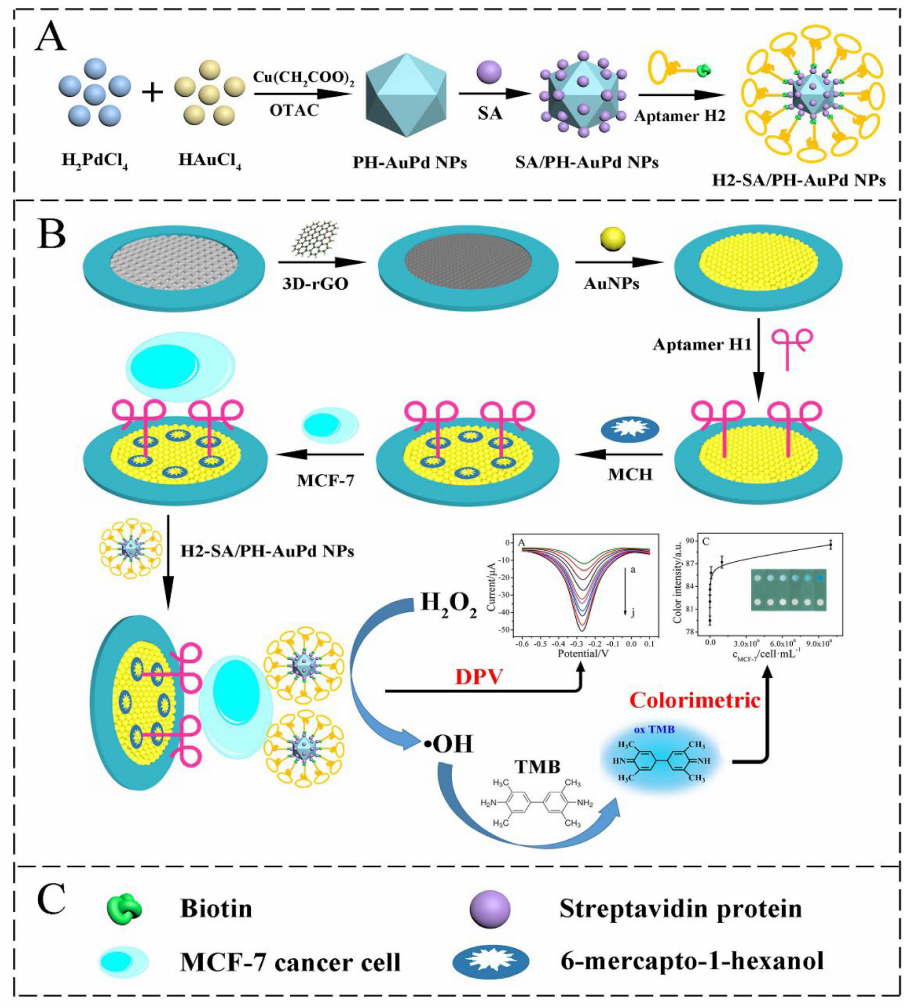
Figure 7. Modification stages of the working electrode in the paper-based biosensor system. ( A ) Prepa- ration of the aptamer-streptavidin-polyhedral AuPd alloy nanoparticle structure (H1-SA/PH-AuPd NPs) ( B ) the total analysis procedure for MCF-7 cells. Reprinted with permission from Ref. [93]. Copyright 2018,